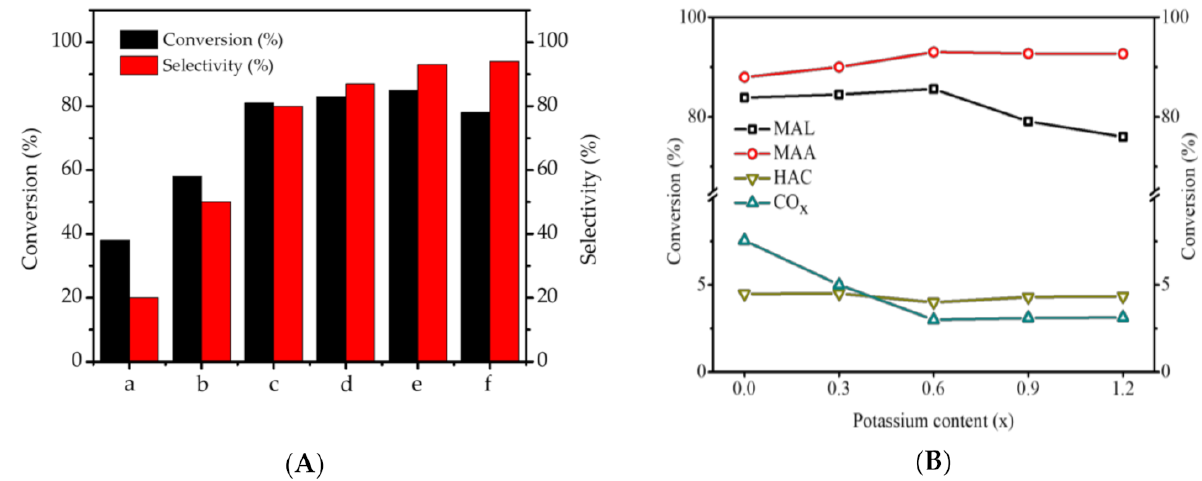
Figure 8. ( A ) Catalytic performance of different catalysts for oxidation MAL to MAA (a: HPVA, b: CsHPVA, c: CsNH 4 PVA, d: CuCsNH 4 PVA, e: K 0.6 CuCsNH 4 PVA, f: K 1.2 CuCsNH 4 PVA). ( B ) Catalytic performance as a function of x value in K x CuCsNH 4 PVA. Space velocity, 1286 h − 1 ; temperature, 310 ◦ C; reactor inlet composition: 3.3% v/v MAL, 9.3% v/v O 2 , 17.4% v/v H 2 O and N 2